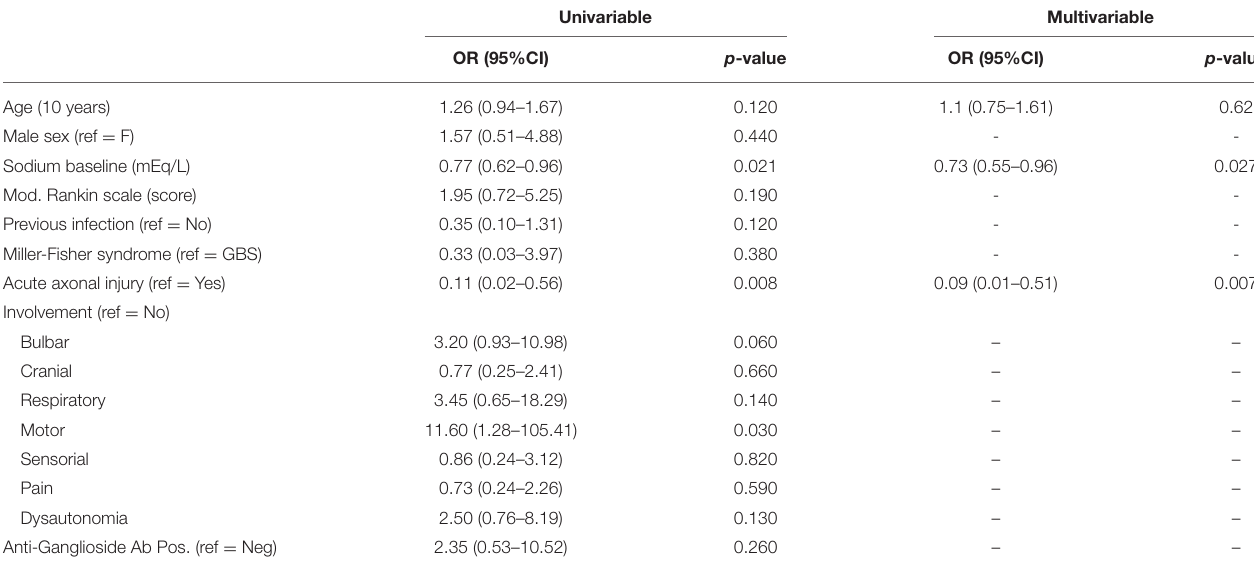
TABLE 2 | Association between baseline features and residual disability at discharge.